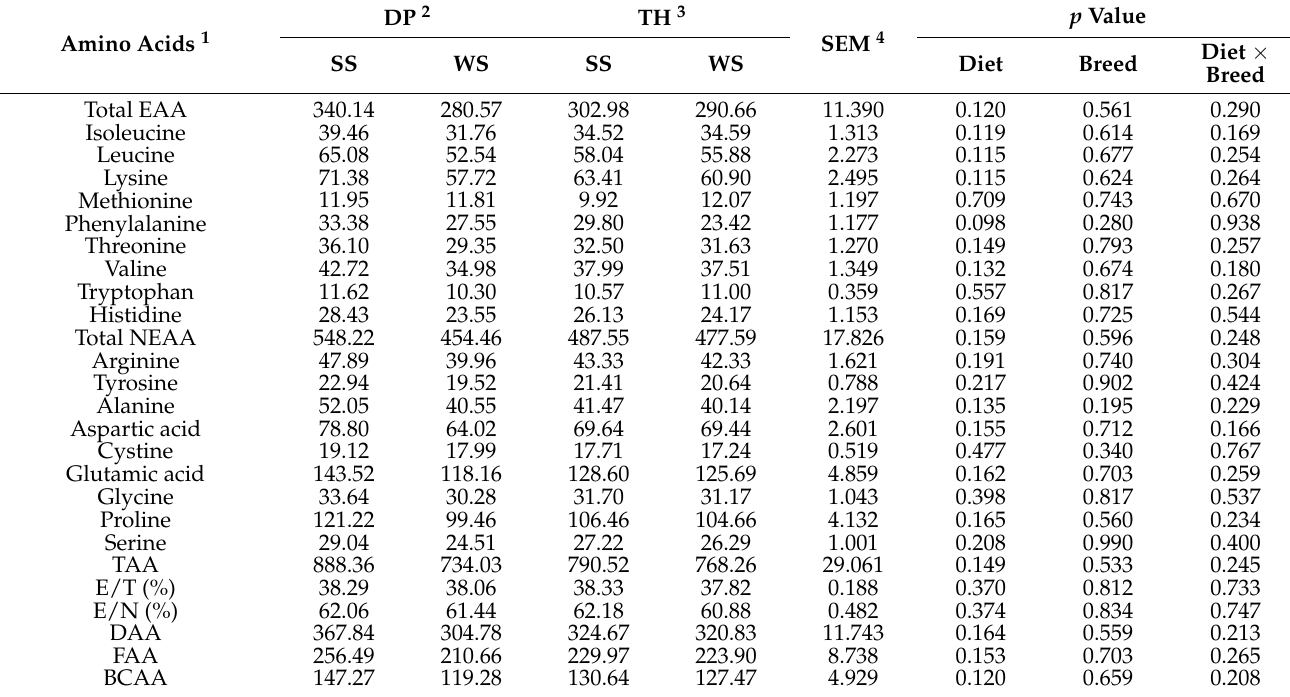
Table 5. Effect of silage diet and breed on amino acid content (g/kg on dry matter basis) of longissimus dorsi ( n = 7 per group).